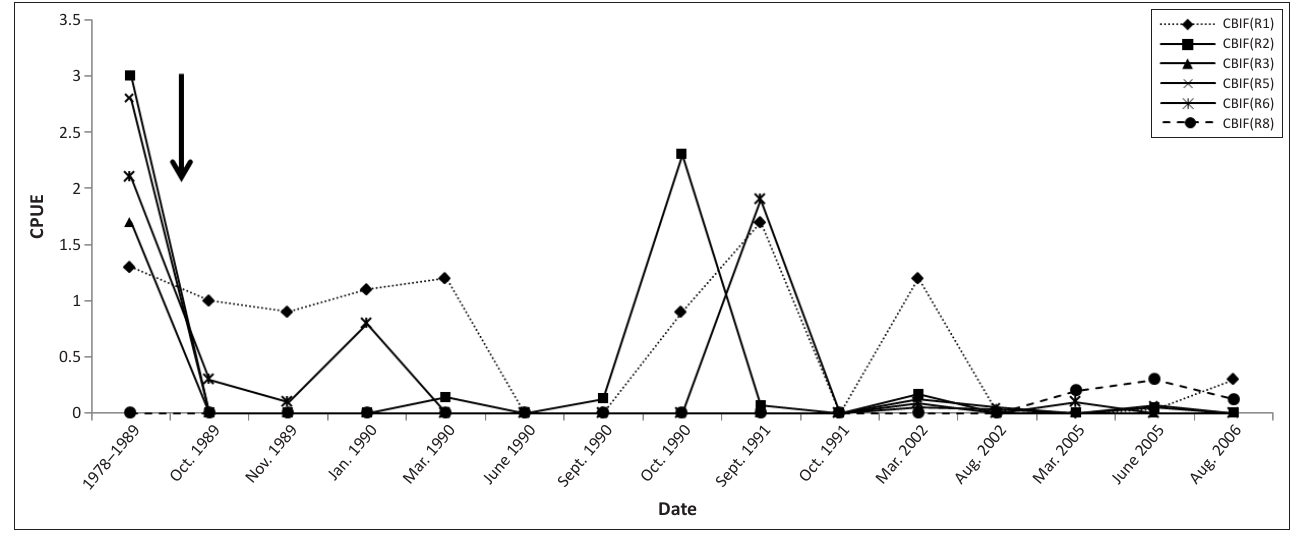
FIGURE 3: Temporal trends in the catch per unit effort (number of fish per minute) of Chiloglanis bifurcus collected in the Elands River between 1978 and 1989 (mean of available data) and between October 1989 and 2006. Arrow depicts the occurrence of the 1989 black liquor spill into the Elands